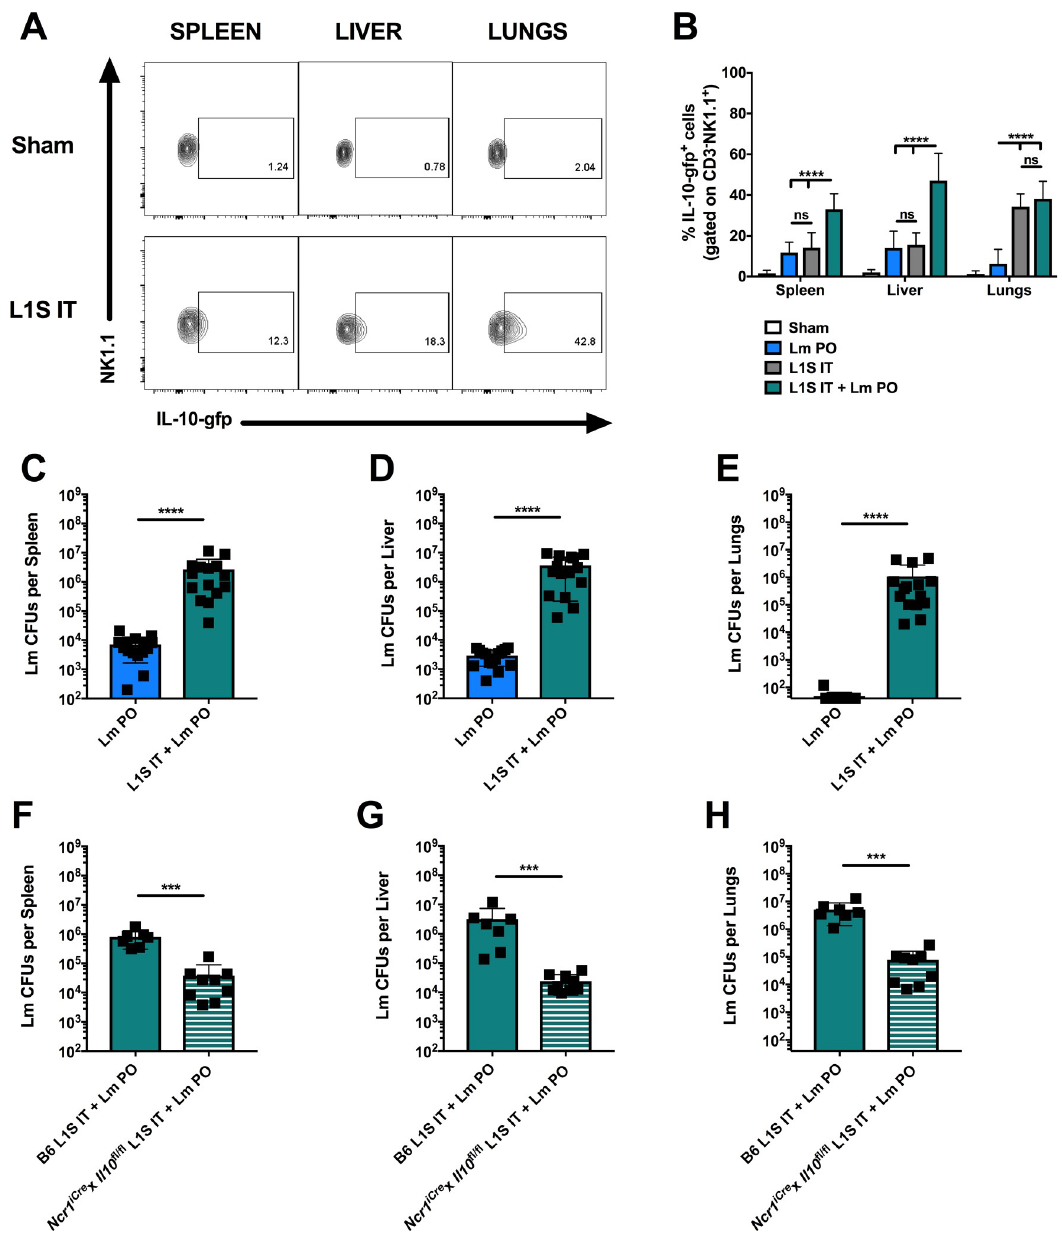
Fig 6. Pulmonary instillation of a bacterial protein suffices to stimulate NK cell IL-10 production and increase peripheral burdens of orally-inoculated Lm . B6. tiger ( Il10 -gfp reporter) male and female age-matched mice were infected with sham control or treated with 100ug L1S intratracheally (IT) and harvested at 3 dpi. (A) Representative flow plots of reporter staining in CD3 - NK1.1 + NK cells in indicated tissues. B6. tiger ( Il10 -gfp reporter) male and female age-matched mice were infected with sham control, Lm PO, L1S IT, or L1S IT + Lm PO and harvested at 3 dpi. (B) Quantitation of percent CD3 - NK1.1 + NK cells that stained positive for IL- 10-gfp + in spleens, livers, and lungs. Data represent mean ± SD, Two-way ANOVA, pooled from 2 experiments, 8 mice per group, ���� p < 0.0001 between indicated groups. Lm burdens were enumerated from (C) spleens, (D) livers, (E) lungs. Data represent mean ± SD, Mann-Whitney t-test, pooled from 3 experiments, 15 mice per group, ���� p < 0.0001. C57BL/6J (B6) and Ncr1 iCre x Il10 fl/ fl male and female age-matched mice were infected with L1S IT + Lm PO and harvested at 3 dpi. Lm burdens were enumerated from (F) spleens, (G) livers, (H) lungs. Data represent mean ± SD, Mann-Whitney t-test, pooled from 2 experiments, 7–9 mice per group, ��� p <